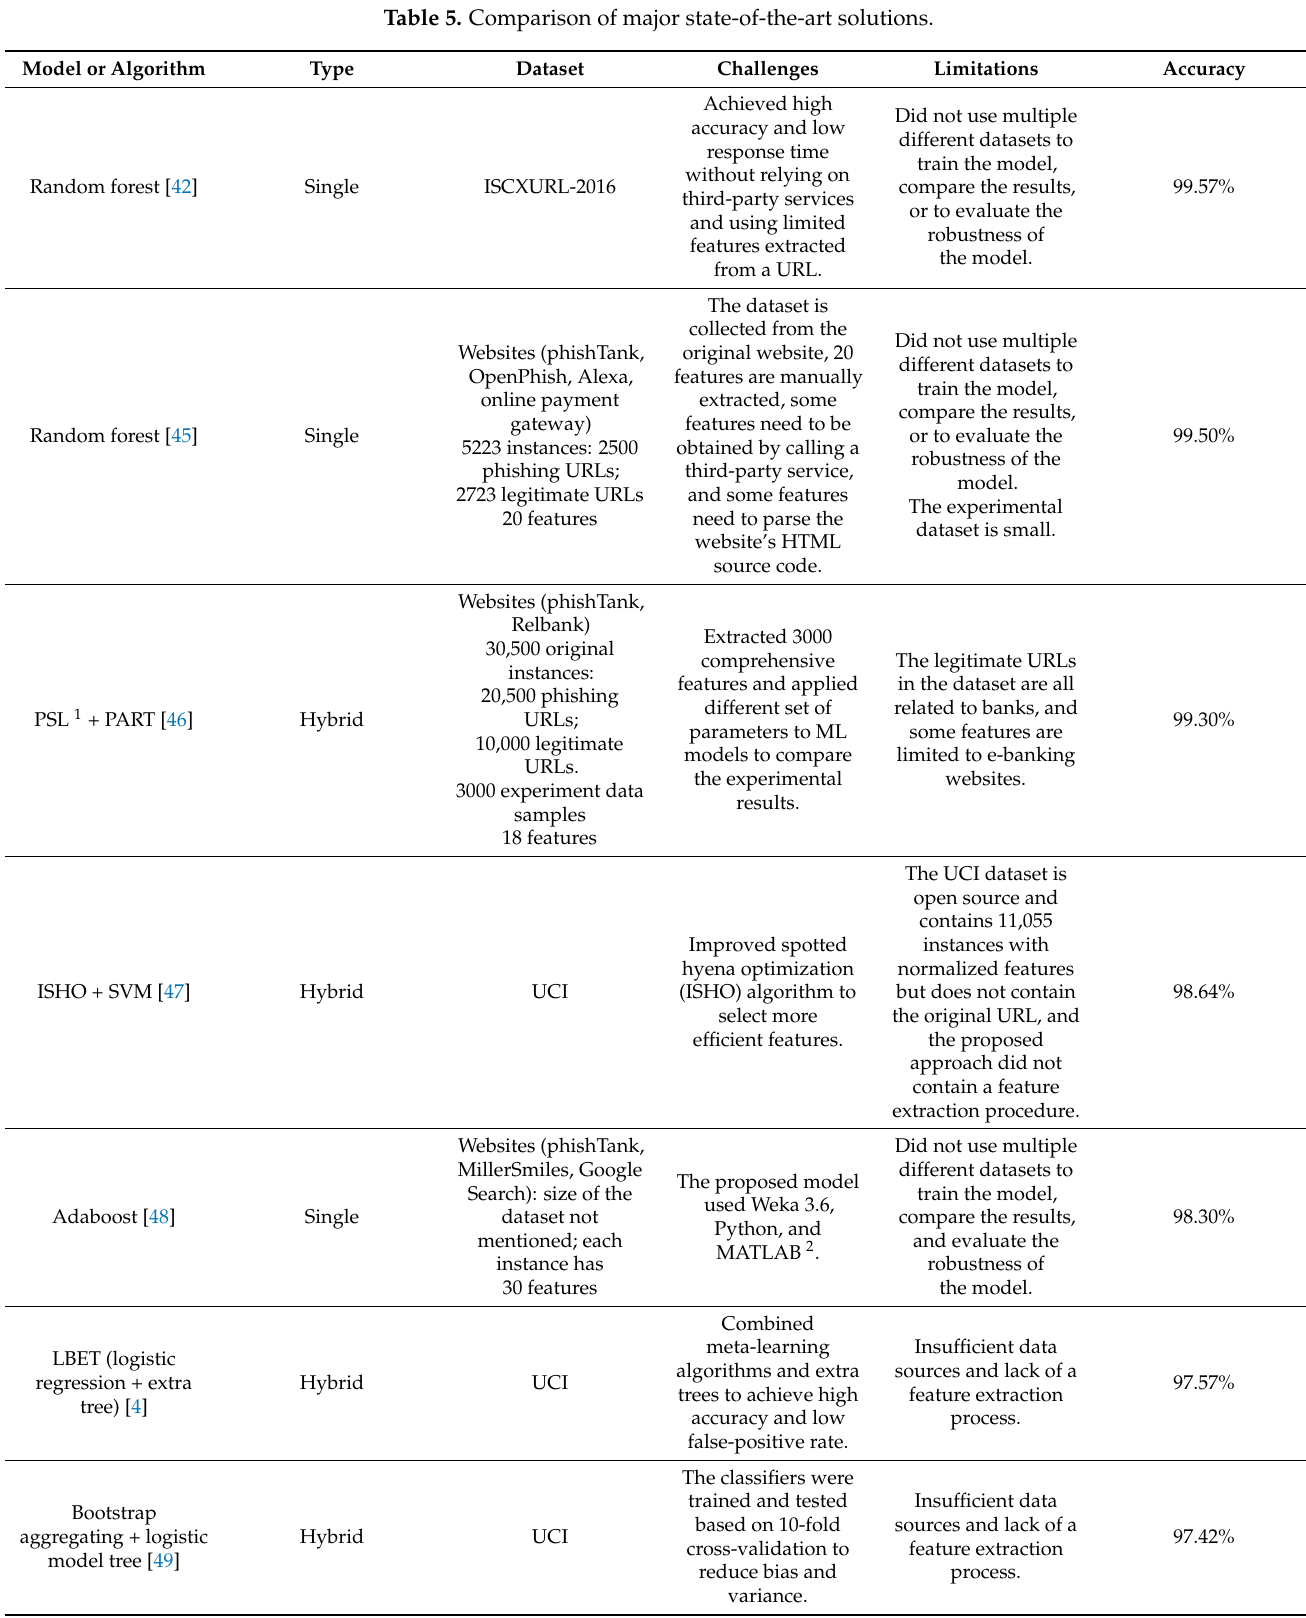
Table 5. Comparison of major state-of-the-art